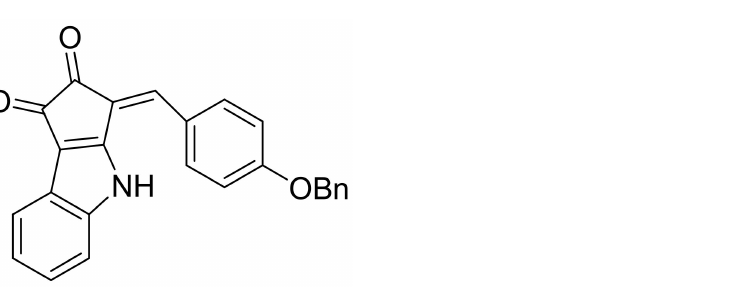
Figure 7. Analogue of nostodione that exhibited the highest antiparasitic activity against Toxoplas- magondii (IC 50 = 4.6 µ